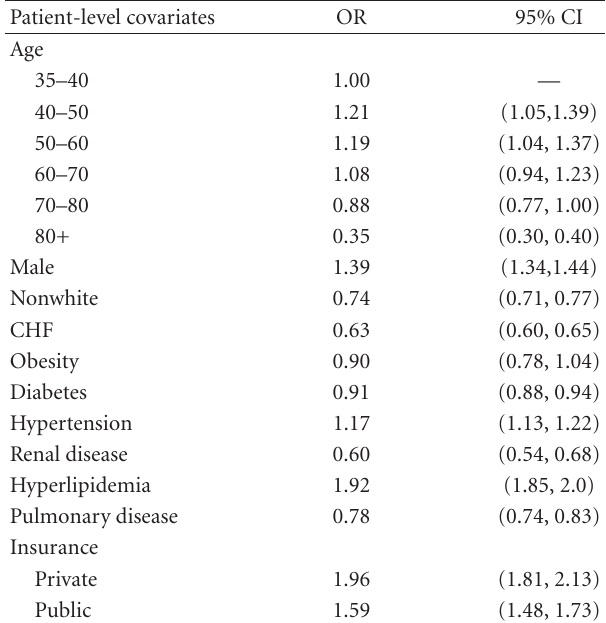
Percentage of households below poverty line. Table 2: Odds ratio (OR) and 95% confidence interval (CI) for patient-level